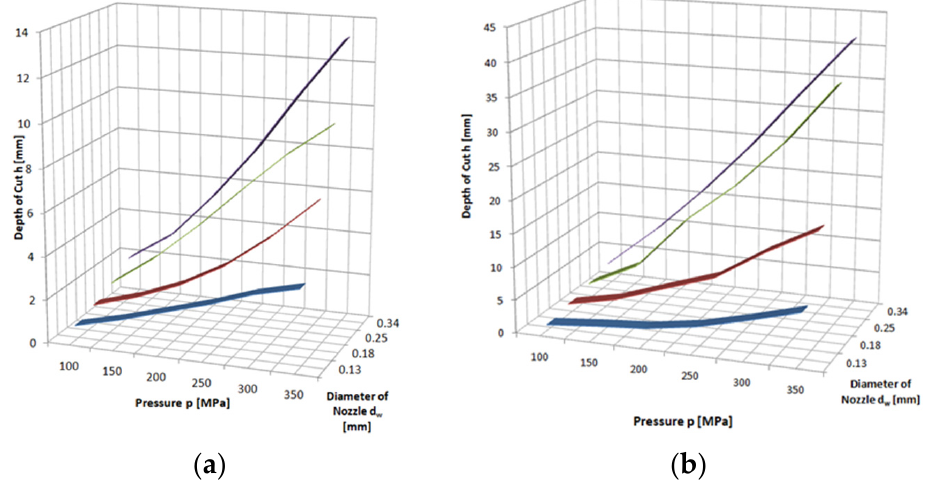
Figure 5. Influence of pressure and waterjet diameter on the depth of the cut of: ( a ) granite and ( b ) sandstone with a pure waterjet: feed speed v p = 3 mm·s − 1 .